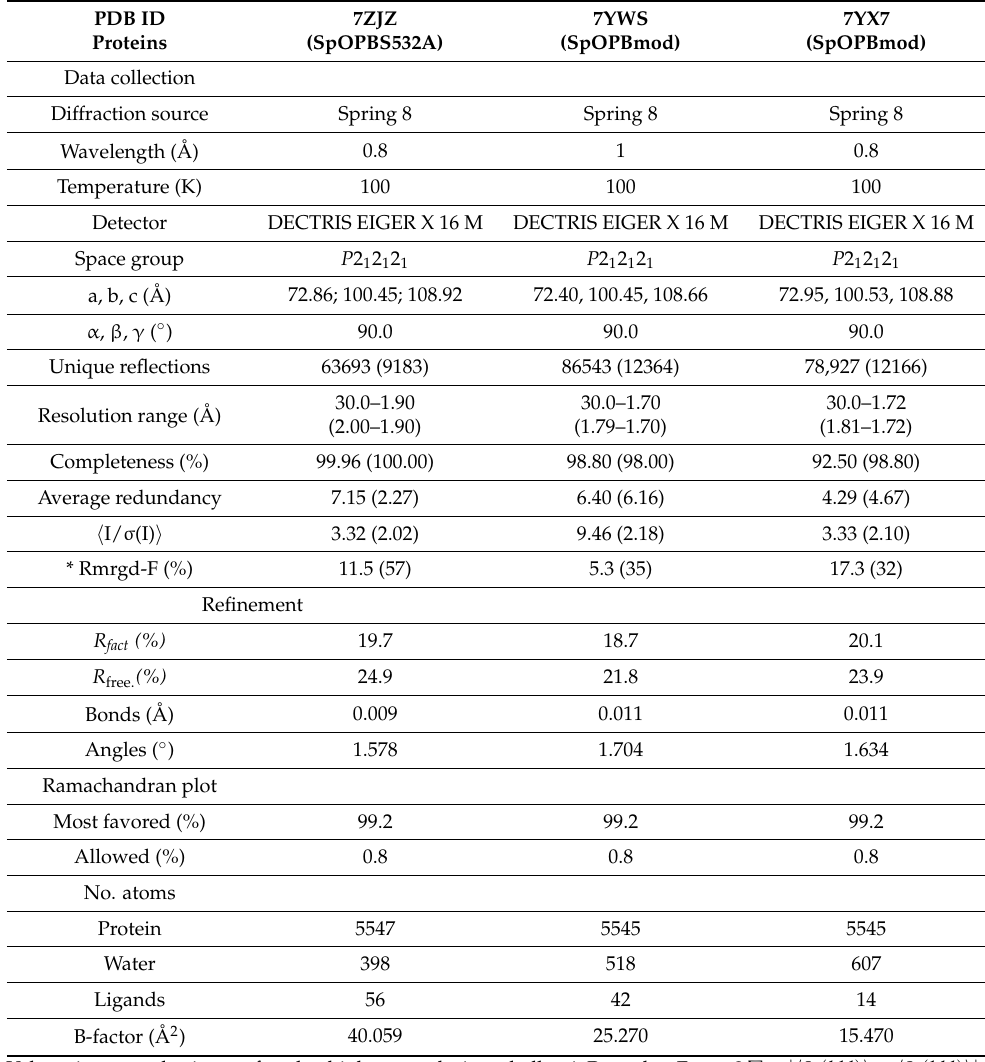
Table 1. Data collection, processing, and